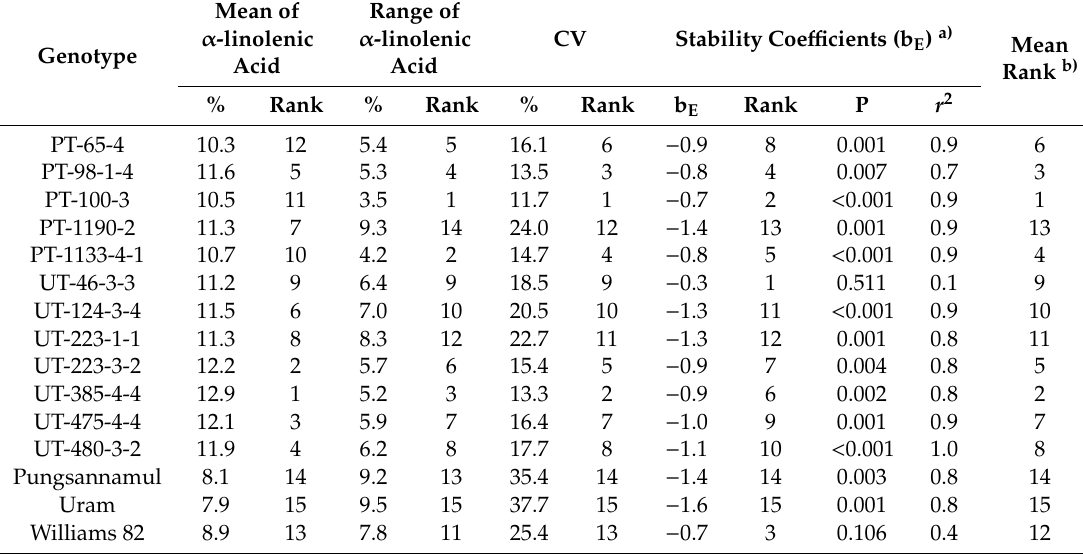
Table 6. Stability parameters: range, coe ffi cient of variation (CV), environmental stability coe ffi cient (b E ), and coe ffi cient of determination ( r 2 ) for mean α -linolenic acid concentration of twelve elevated α -linolenic acid genotypes and three genotypes with normal α -linolenic acid concentration in eight di ff erent